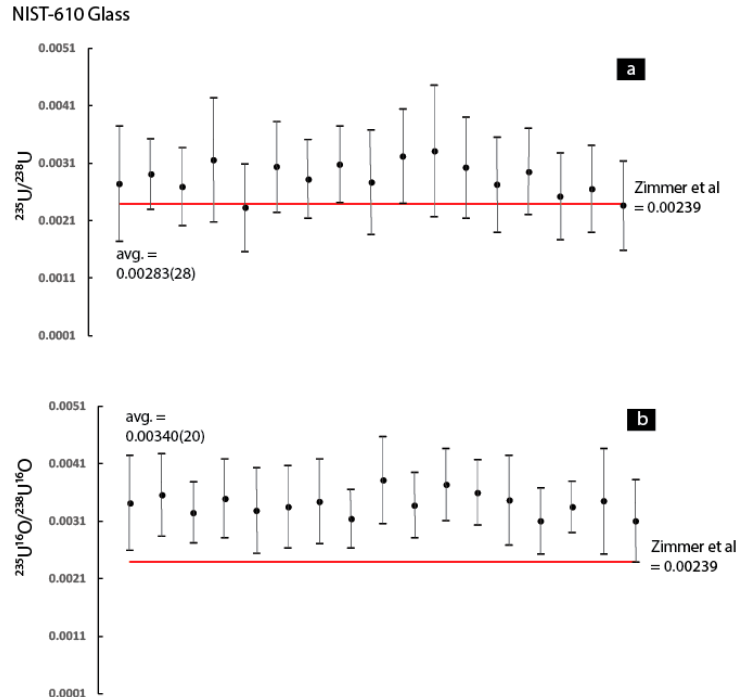
Figure 8. Plot of each analysis’s ( a ) 235 U / 238 U and ( b ) 235 U 16 O / 238 U 16 O ratio and its associated 1 σ uncertainty relative to the solution MC-ICP-MS value (red line), for UO 2 (NO 3 ) 2 · 6(H 2 O) analyzed using the 200 pA primary beam.